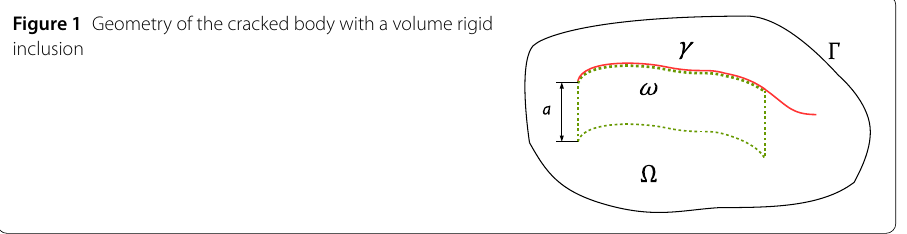
Figure 1 Geometry of the cracked body with a volume rigid